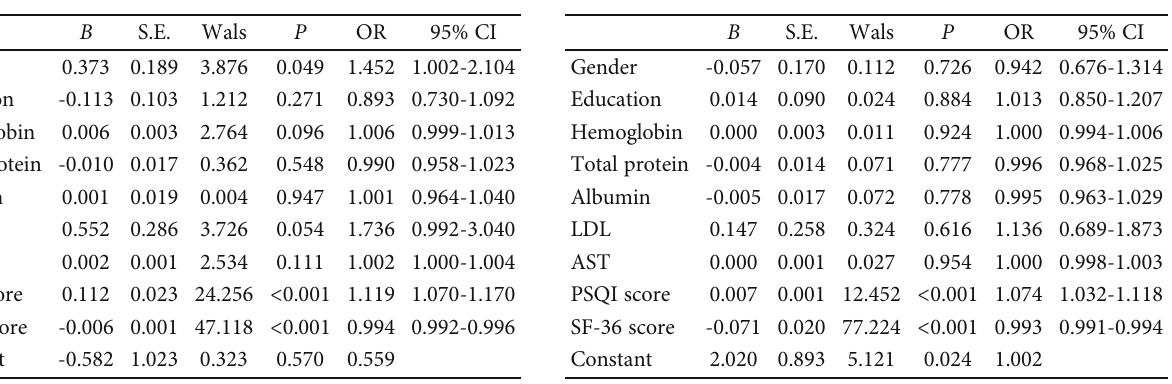
Table 7: Logistic regression of anxiety symptom-related factors in patients.